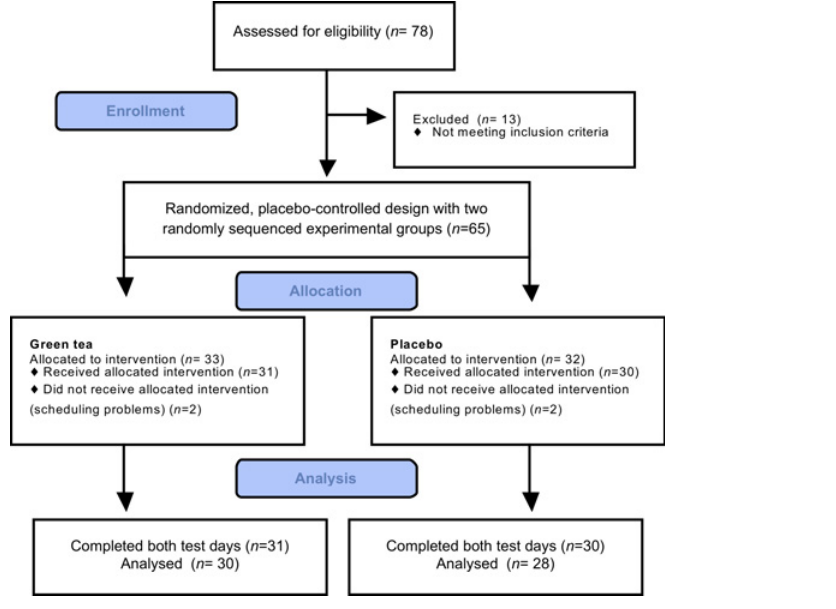
Fig 1. CONSORT flow